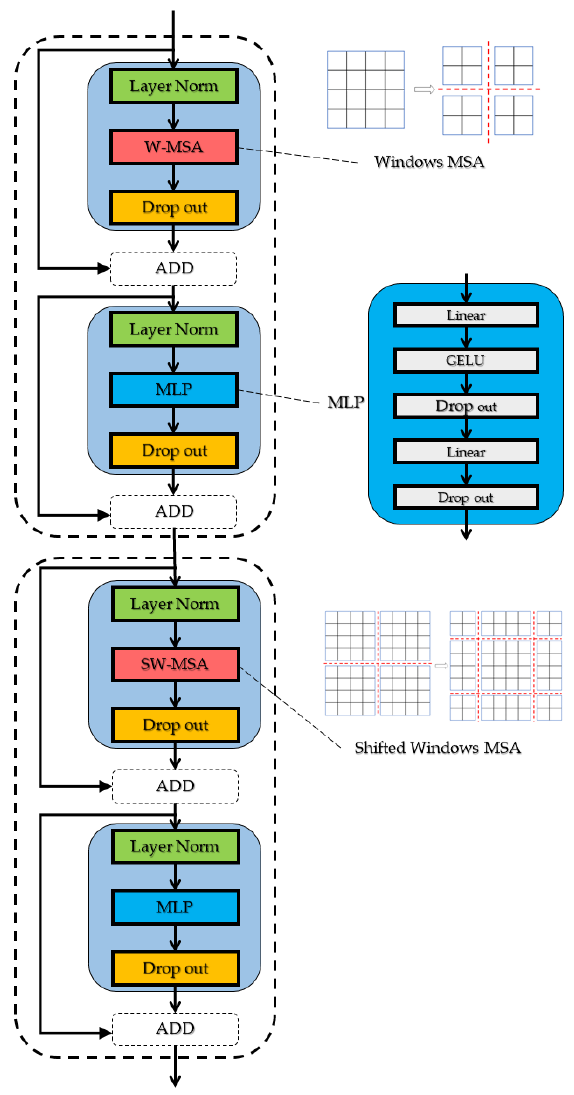
Figure 5. The basic self-attention module, which constitutes the backbone network, consists of W- MSA and SW-MSA connected in series.